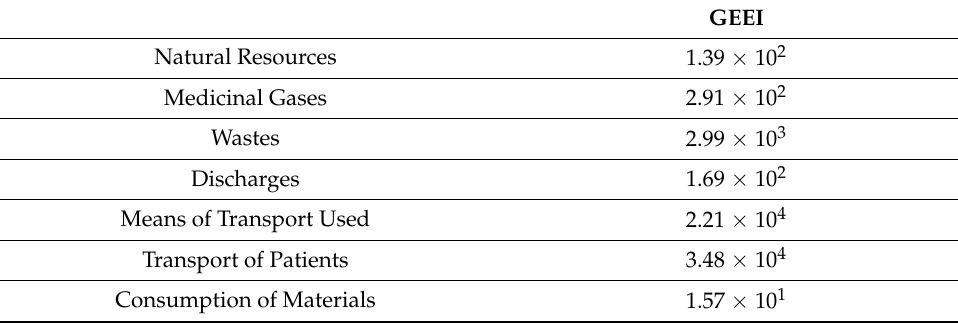
Table 3. Single-value Global Environmental Efficiency Index associated with the studied hospital’s activities and services provided in